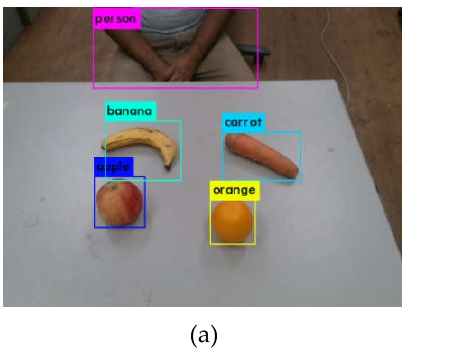
Table 5. The emotional valences of a priori LH emotion to objects in the